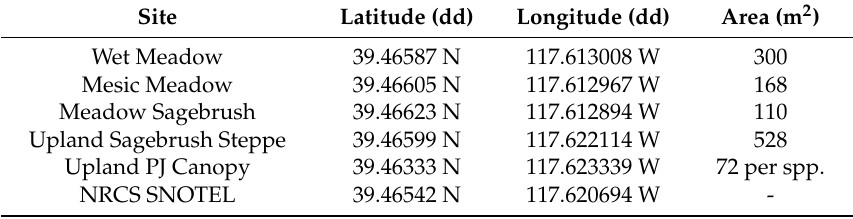
Table 1. Site locations used in this study within the Porter Canyon Experimental Watershed. Air temperature located at NRCS SNOTEL. Volumetric soil water content located at NRCS SNOTEL, upland sagebrush steppe, and pinyon and juniper sites. Soil temperature located at the pinyon and juniper site. Depth to groundwater well located at wet and mesic meadow region of interest.